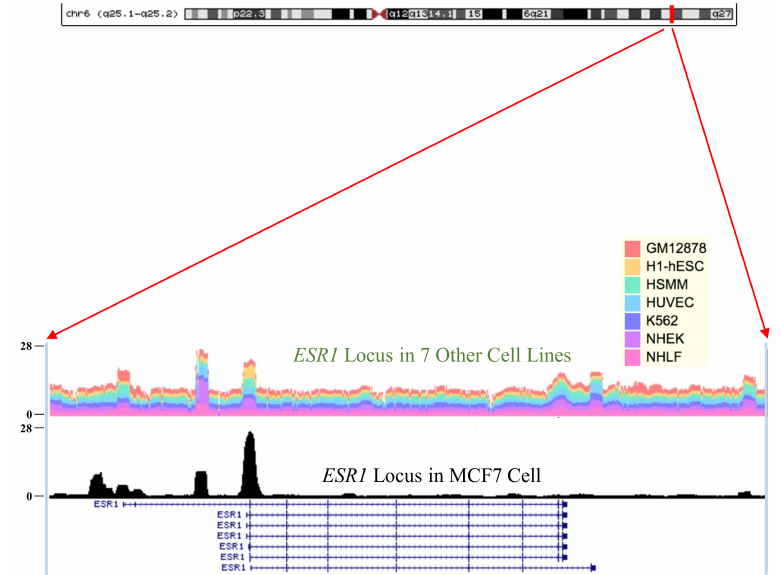
Figure 2. Strong H3K4me3 epigenetic modification signals within the ESR1 locus in human breast adenocarcinoma MCF-7 cells. H3K4me3 signals in the MCF-7 ESR1 locus are compared with the stacked spectra of those signals in the seven other cell lines, GM12878 (human lymphoblastoid cell), H1-hESC (H1-human Embryonic Stem Cell), HSMM (Human Skeletal Muscle Myoblast cell), HUVEC (Human Umbilical Vein Endothelial Cell), K562 (human immortalised myelogenous leukemia cell), NHEK (Normal Human Epidermal Keratinocytes), and NHLF (normal human lung fibroblasts). The y -axis indicates the intensity of the epigenetic modification H3K4me3 at each genomic